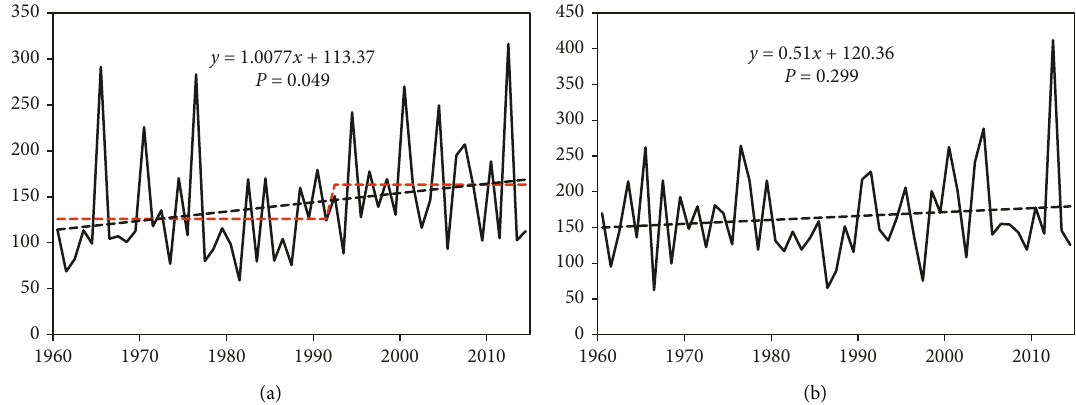
y = 1.0077 x + 113.37 P = 0.049